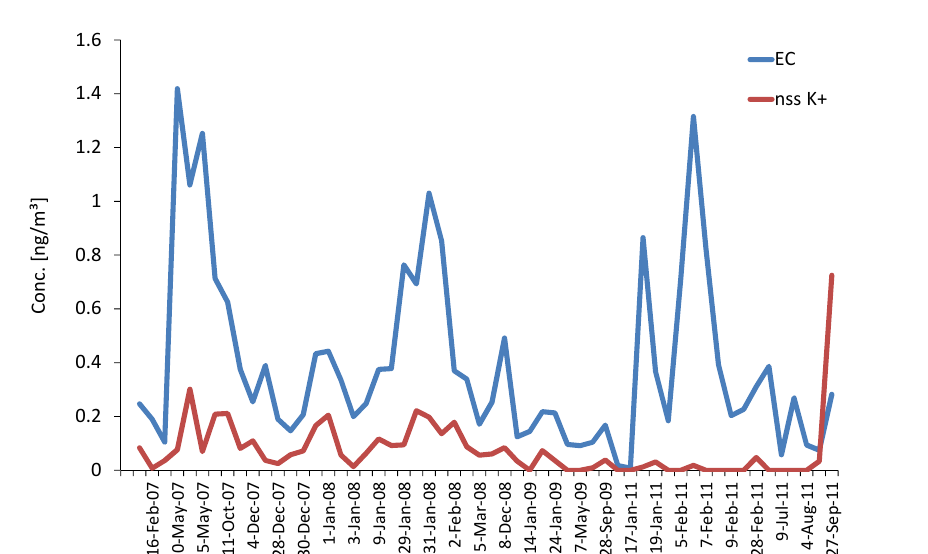
Figure 8. Time series of nss-potassium (nss-K + ) and elemental carbon (EC) measured during air mass inflow from Africa revealing similar temporal